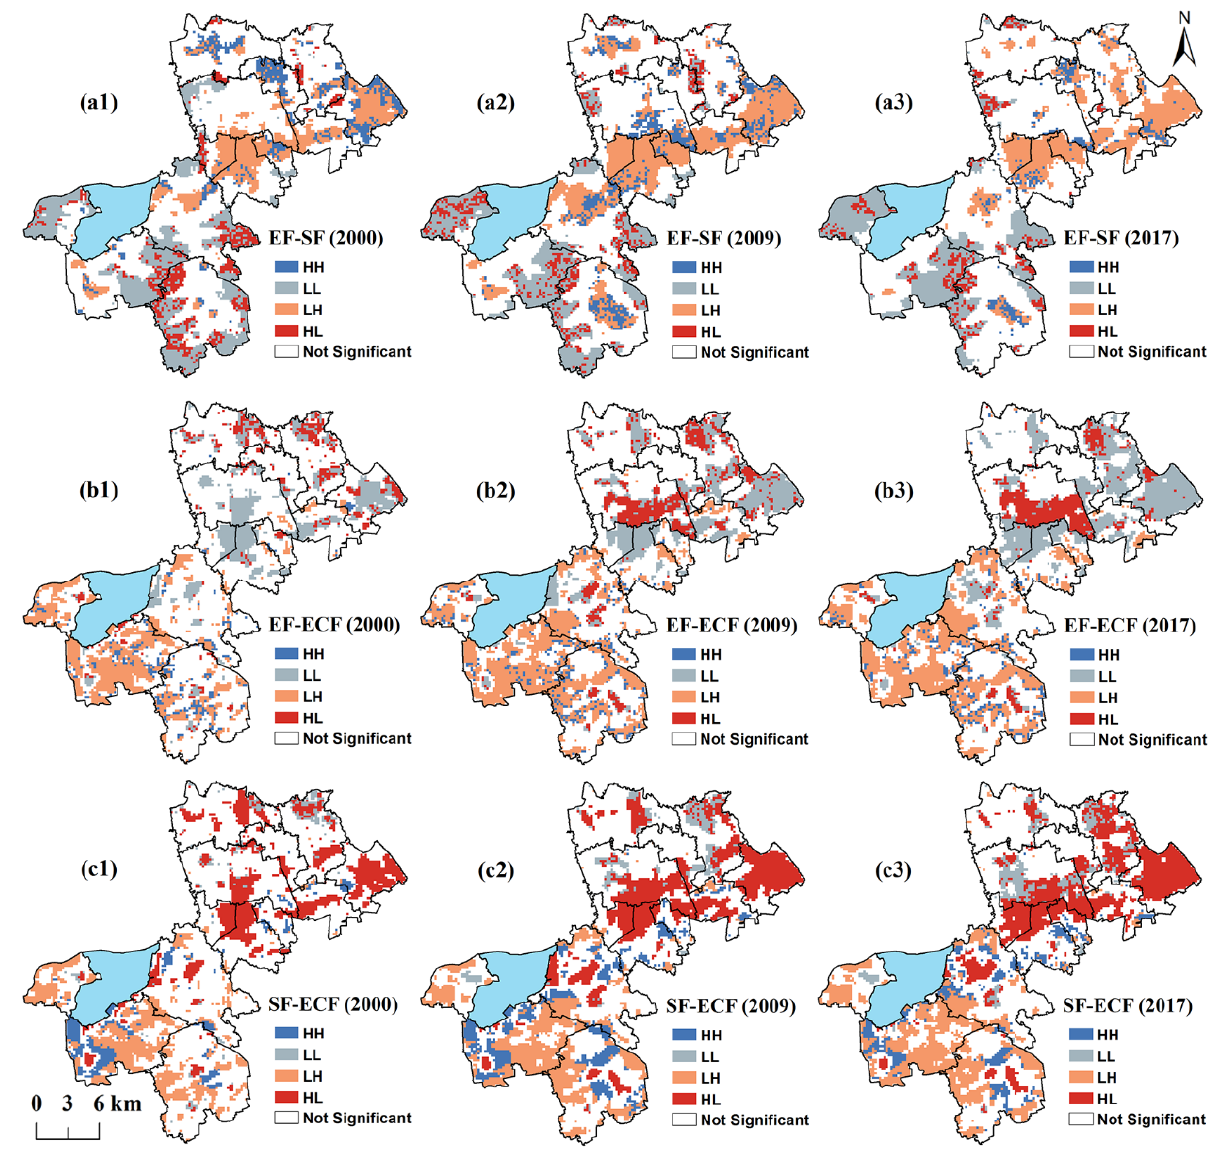
Figure 5. Spatial synergy and trade ‐ off of land use primary functions in Qingpu District during 2000–2017. The results of spatial synergy and trade ‐ off include economic function (EF) and social function (SF) in 2000 ( a1 ), 2009 ( a2 ) and 2017 ( a3 ); economic function (EF) and ecological function (ECF) in 2000 ( b1 ), 2009 ( b2 ) and 2017 ( b3 ); social function (SF) and ecological function (ECF) in 2000 ( c1 ), 2009 ( c2 ) and 2017 ( c3 ).